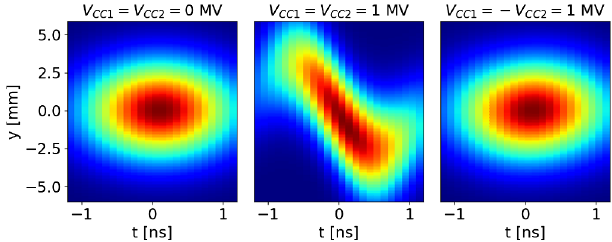
FIG. 3. Intra-bunch motion from three different cases measured with the HT monitor. Left: crab cavities switched off (voltage ¼ 0 ). Center: synchronous crabbing with both cavities in phase corresponding to V CC ≈ 2 MV total voltage ( V CC 1 ¼ V ¼ 1 MV). Right: cavities in counterphase, corresponding CC 2 to residual V CC ≈ 60 kV total voltage.